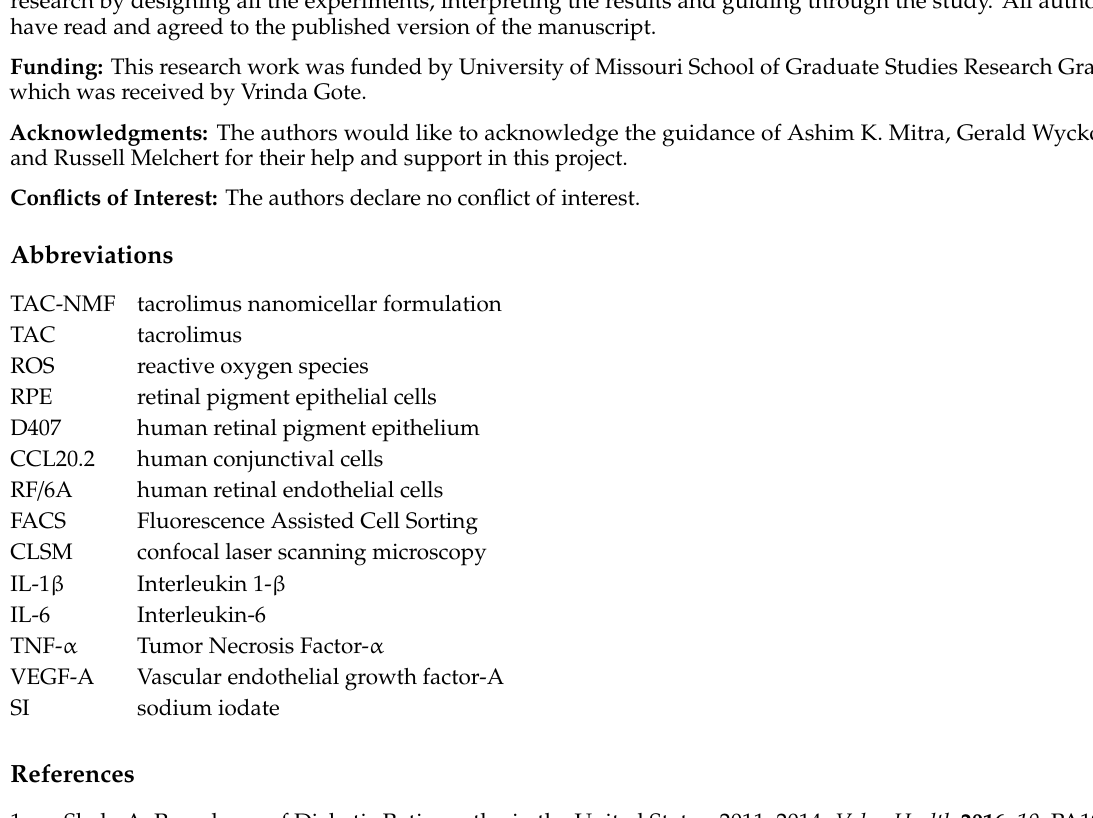
s1. Figure S1. In-vitro cytotoxicity determination by LDH Assay. (A) LDH (%) of D407, CCL 20.2 and RF / 6A cells after treatment with placebo NMF composed of mixture of HCO-40 and OC-40 amphiphilic polymers ranging from 20–42.5 mg / mL of total HCO-40 and OC-40 in a fixed ratio of (HCO-40:OC-40: 3.5:1) for 24 h. (B) Cell Viability (%) of retinal pigment epithelium cells (D407) after treatment with TAC and TAC-NMF for 24 h. (C) Cell viability (%) of conjunctival cells (CCL 20.2) after treatment with TAC and TAC-NMF for 24 h. (D) Cell viability (%) of choroidal endothelial cells (RF / 6A) after treatment with TAC and TAC-NMF for 24 h. (* p ≤ 0.05 and ** p ≤ 0.01as compared to the corresponding control group, here